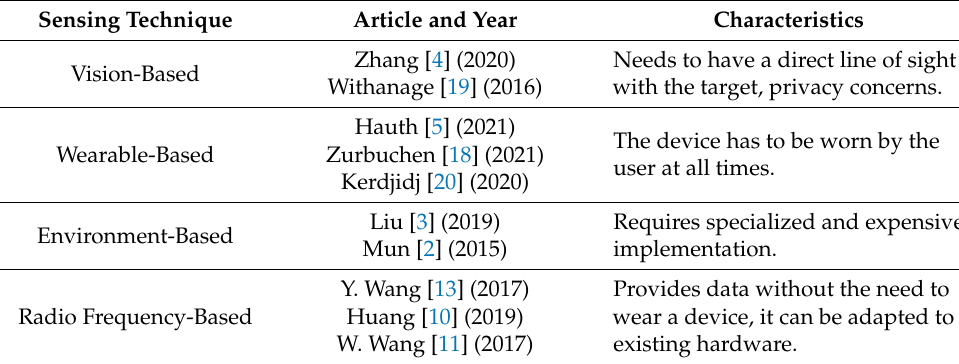
Table 1. Approaches to fall detection